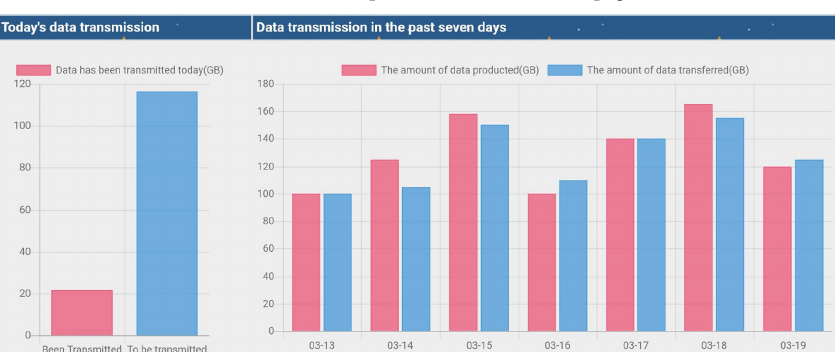
Figure 9: The first part of visualization web pages.